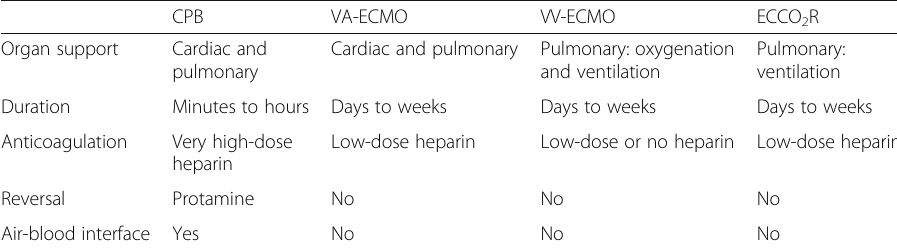
Table 1 ECLS modalities CPB VA-ECMO VV-ECMO ECCO 2 R Organ support Cardiac and Cardiac and pulmonary Pulmonary: oxygenation pulmonary and